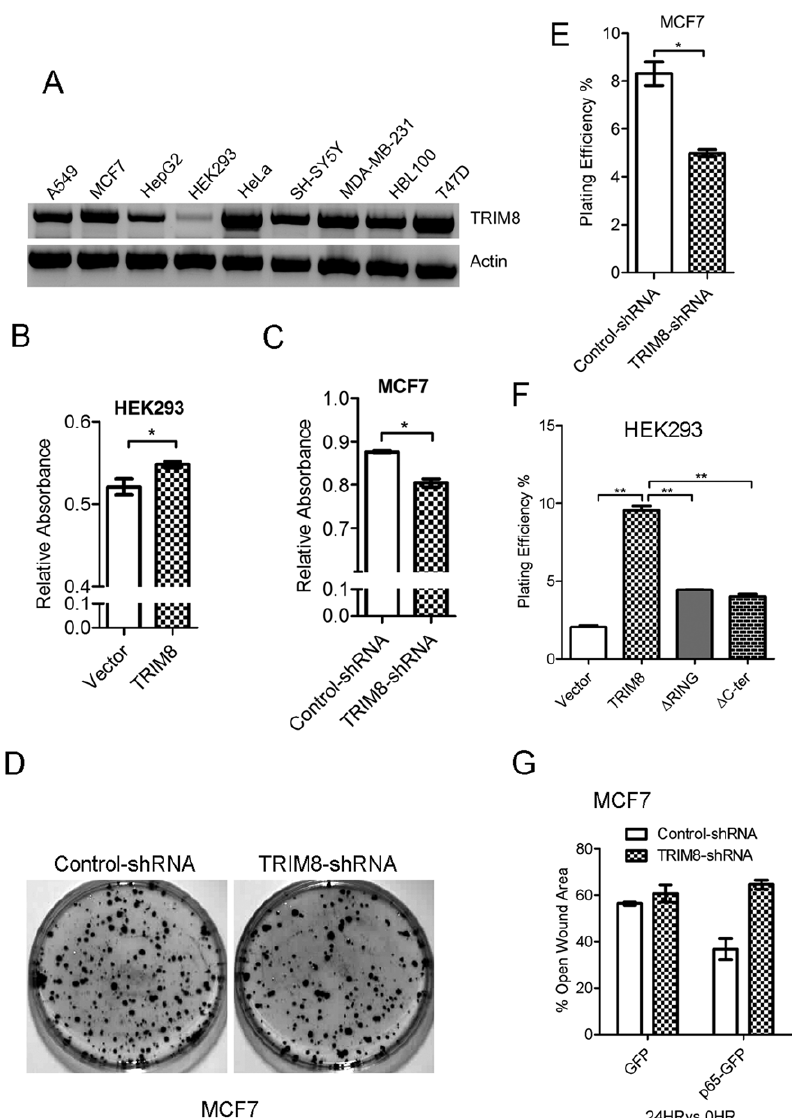
Figure 5. TRIM8 knockdown suppresses clonogenic and migration ability of the cells. (A) Analysis of TRIM8 expression in different cell lines. Total RNA was isolated from indicated cell lines and RT-PCR was performed as described in materials and method section. (B) TRIM8 overexpression increases proliferation of HEK293 cells. The cells were transfected with vector and TRIM8 and cellular proliferation was monitored by MTT assay. (C) TRIM8 knockdown decreases proliferation of MCF7 cells. The cells were transfected with vector and TRIM8 and cell proliferation was cellular monitored by MTT assay (D) TRIM8 knockdown suppresses clonogenic ability of MCF7 cells. The cells were transfected with TRIM8-shRNA and control-shRNA, clonogenic activity assessed as described in method section. (E) TRIM8 knockdown decreases plating efficiency of MCF7 cells. Graphical representation of plating efficiency of TRIM8-shRNA and control-shRNA transfected cells. (F) RING and C-ter region of TRIM8 is essential for regulation of clonogenic ability of MCF7 cells. Graphical representation of plating efficiency of FL-TRIM8, D RING-TRIM8, D C-ter-TRIM8 and vector transfected HEK293 cells. (G) TRIM8 is essential for p65 regulated migration ability of MCF7 cells. The cells were co-transfected with control and TRIM8 shRNA, with vector and p65 and scratch assay performed. Statistical analysis for open wound area formed in p65 overexpression and TRIM8 knockdown cells. Asterisk (*) indicates data changes are statistically significant between groups: p value , 0.05 for SEM of minimum three independent